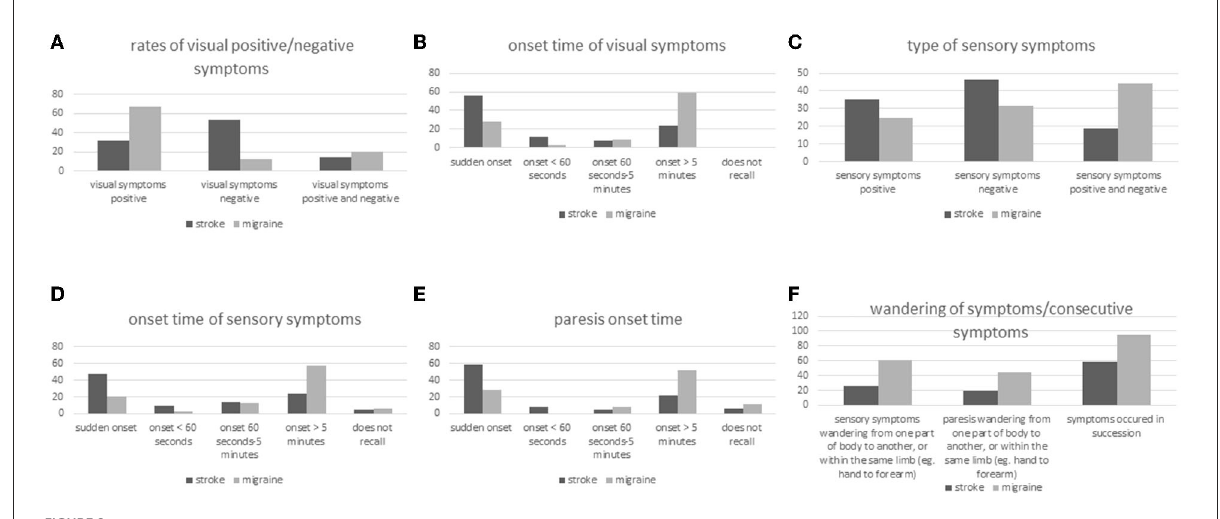
FIGURE2 (A–F) Symptom type, symptom onset, and spreading of symptoms in stroke and migraine patients with